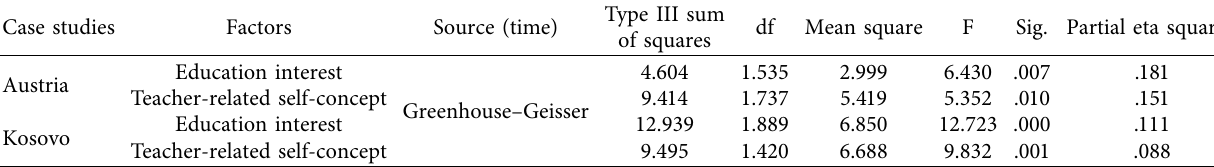
Table 7: Tests of within-subject effects.